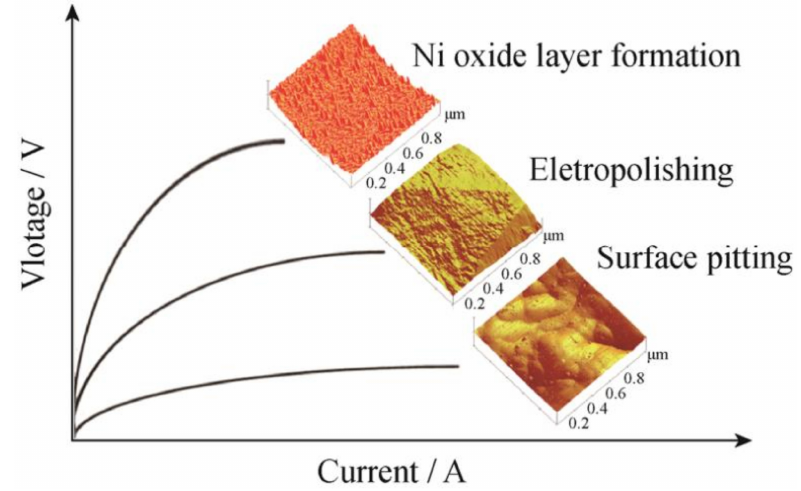
Figure 15. Schematic diagram describing the optimal relationship between the voltage and current for nickel electropolishing, and examples of resulting 10 µ m × 10 µ m surface characteristics via AFM micrographs (reprinted with permission from ref. [62]; Copyright © 2019, University of Science and Technology Beijing and Springer-Verlag GmbH Germany, part of Springer Nature).